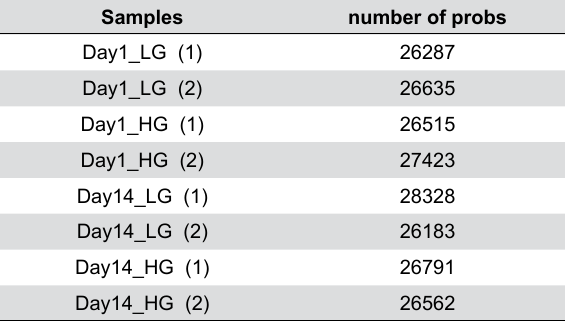
Table S2- The number of detected probes